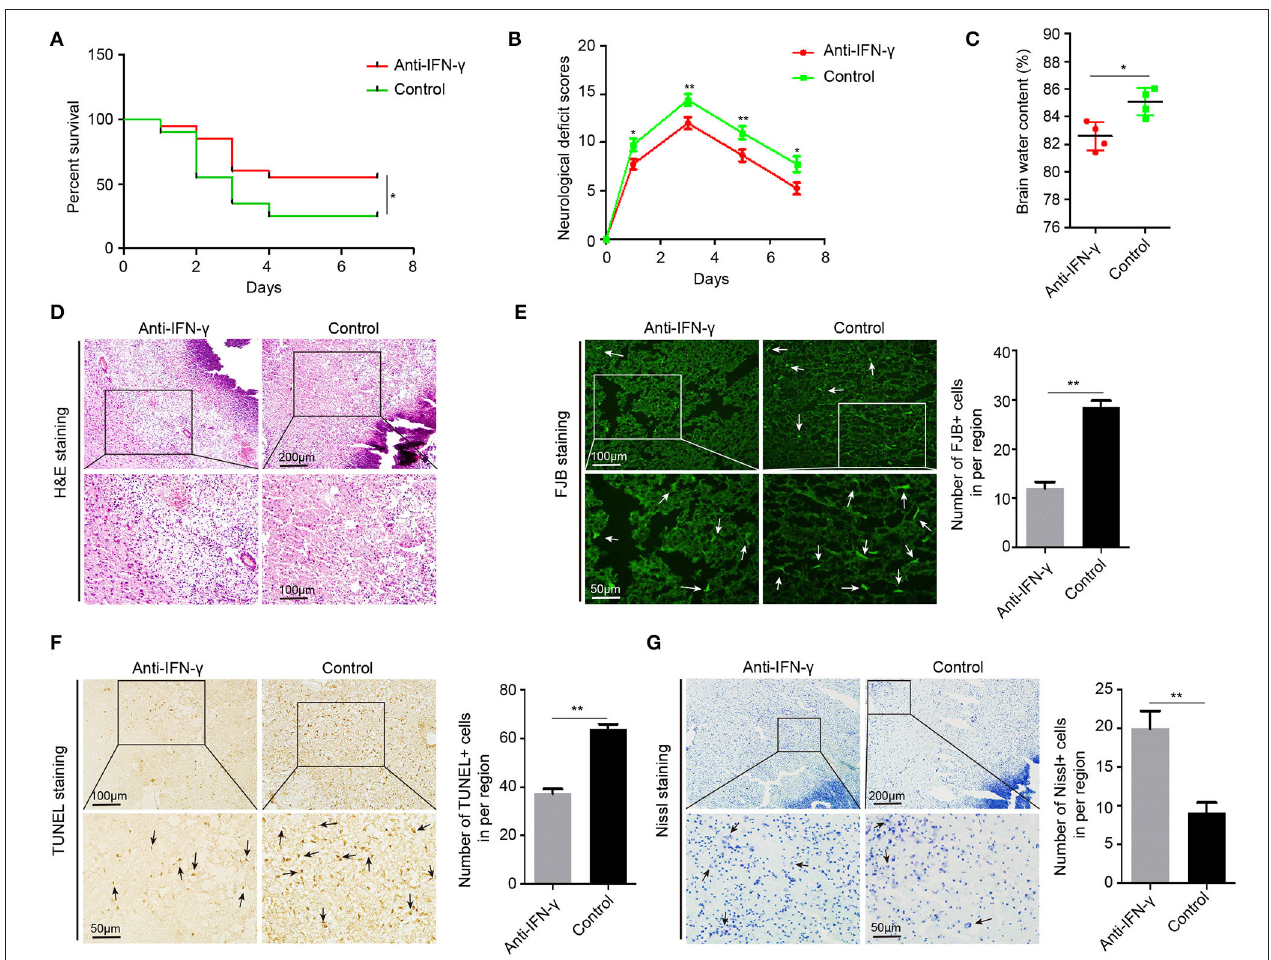
FIGURE 7 | Anti-IFN- γ reduces acute brain injury in aging ICH rats. (A) The neurological deficit scores of 22-month-old ICH rats after treatment with anti-IFN- γ antibody or normal IgG ( n = 12). (B) The mortality of aging ICH rats after treatment with anti-IFN- γ antibody or normal IgG ( n = 20). (C) Level of brain water contents in perihematomal brain tissues in 22-month-old ICH rats 3 days after treatment with anti-IFN- γ antibody or normal IgG ( n = 4). (D) Hematoxylin and eosin (H&E) staining of perihematomal brain tissue derived from 22-month-old ICH rats 3 days after treatment with anti-IFN- γ antibody or normal IgG. Scale bars, 200 µ m at the top and 100 µ m at the bottom. (E) Fluoro-Jade B (FJB) staining and quantification of degenerative neural cells in perihematomal brain tissues derived from 22-month-old ICH rats 3 days after treatment with an anti-IFN- γ antibody or normal IgG. Scale bars, 100 µ m at the top and 50 µ m at the bottom. (F) TUNEL assay and quantification of apoptotic neural cells in perihematomal brain tissues derived from 22-month-old ICH rats 3 days after treatment with anti-IFN- γ antibody or normal IgG. Scale bars, 100 µ m at the top and 50 µ m at the bottom. (G) Nissl staining and quantification of Nissl bodies in perihematomal brain tissues derived from 22-month-old ICH rats 3 days after treatment with anti-IFN- γ antibody or normal IgG. Scale bars, 200 µ m at the top and 50 µ m at the bottom. The bar graphs show the mean ± SEM. p -value determined using the Student’s t -test. * p < 0.05, ** p < 0.01, and *** p <